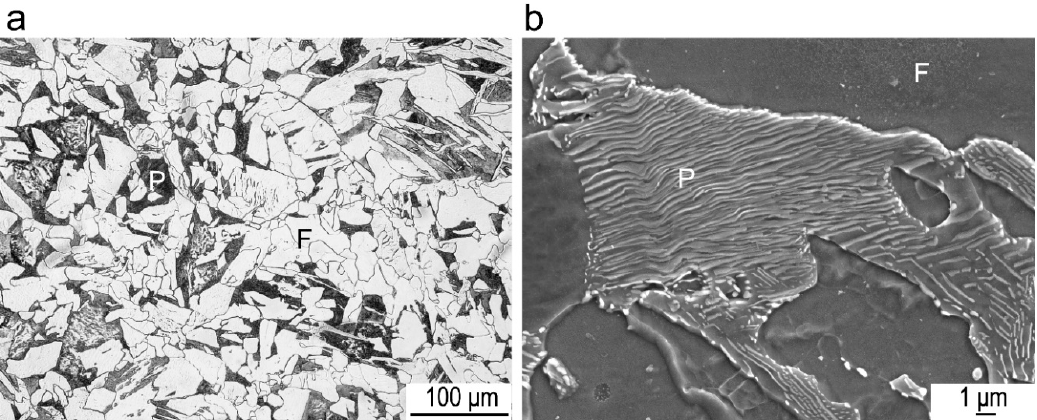
Figure 5. Microstructures after austenitizing for 300 s at 1250 °C and holding at 635 °C for 900 s (15 min): ( a ) OM imaging and ( b ) SEM imaging. F is ferrite and P is pearlite.